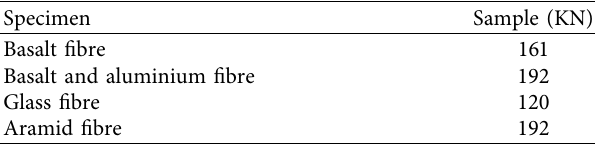
Figure 1: (a) Hand lay-up method of fibre metal laminate [22], (b) specimen for tensile testing, (c) samples of the impact test, and (d) sample for the flexural test. Table 1: experimental value for flexural strength.